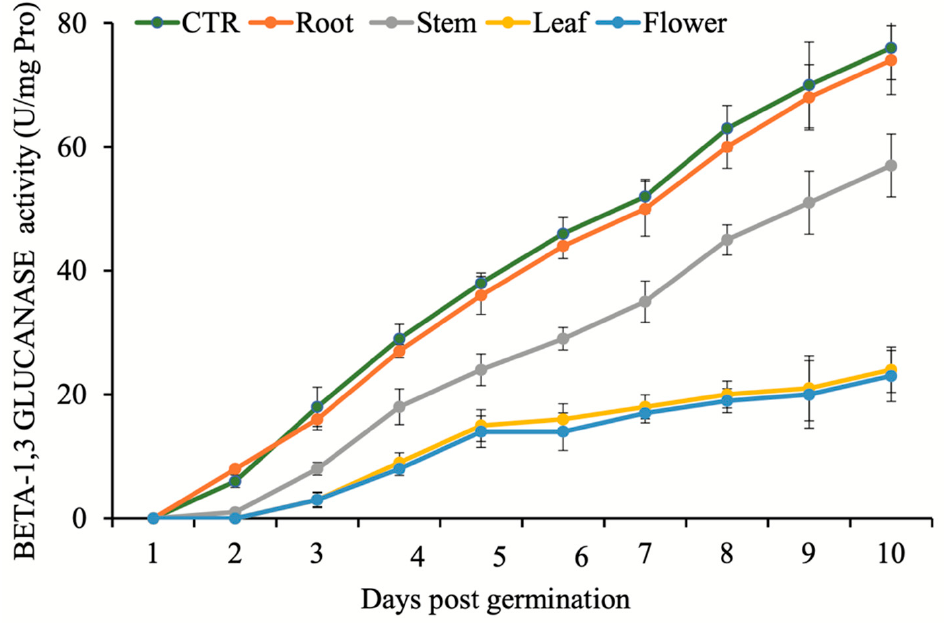
Figure 3. Effect of N. meyeri extracts on beta-1,3 glucanase activity in germinating C. campestris (dodder) seeds. Dodder seeds were treated either by distilled water (CTR) or extracts from different N. meyeri plant parts. Error bars represent standard errors calculated from three biological replicates.